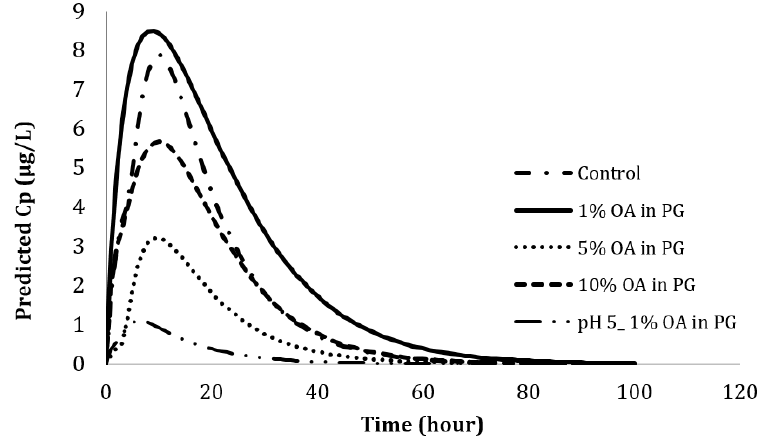
Figure 5. Predicted transport domperidone profiles in vivo by WinsAAM . Table II. Parameters of transdermal transport in vitro of domperidone analyzed by WinSAAM a OA 1 % in